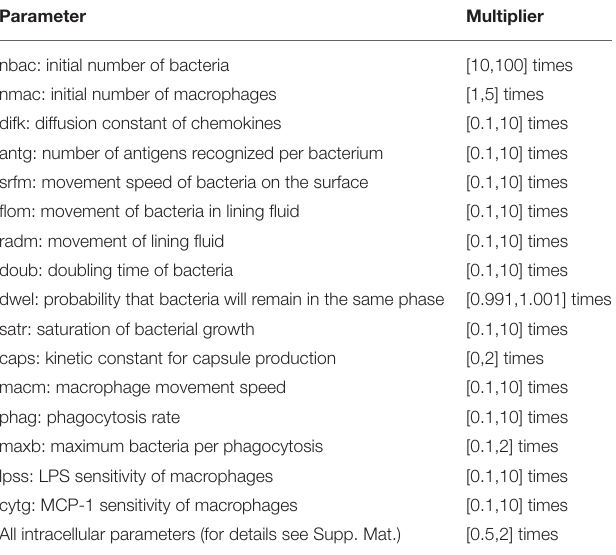
TABLE 1 | Tissue-level parameter search space. Parameter Multiplier